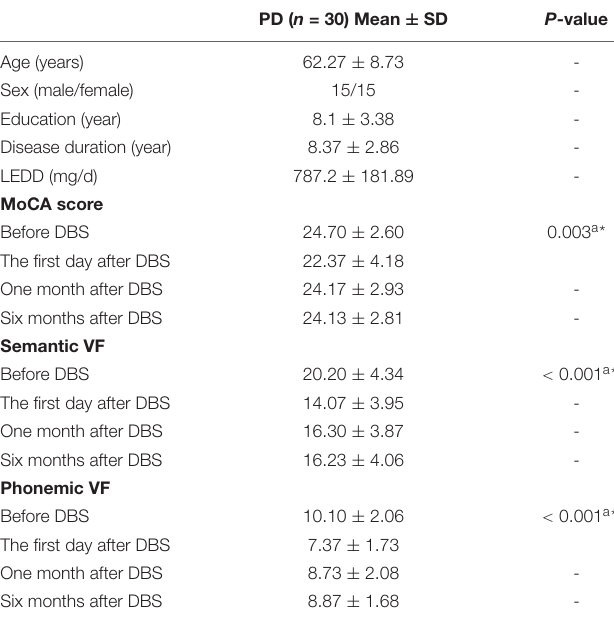
TABLE 1 | Demographic and clinical data of all